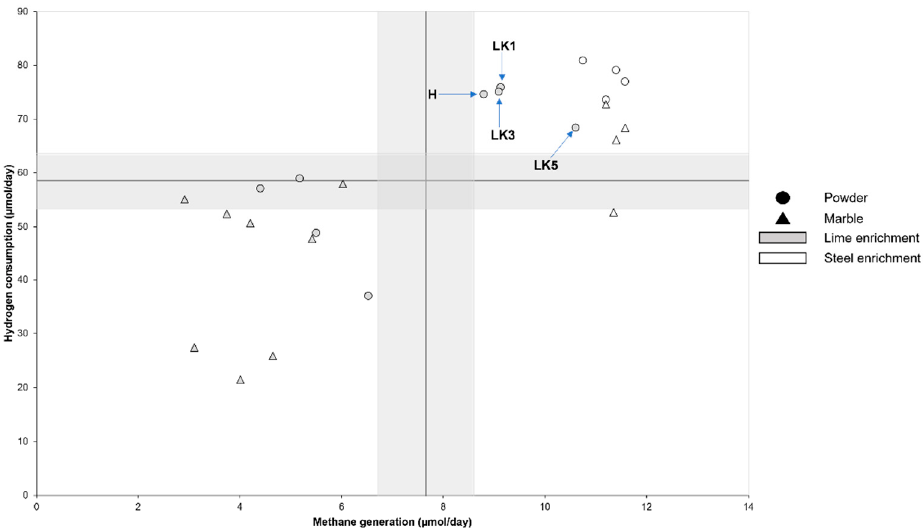
Figure 3. Comparison of hydrogen consumption and methane generation rates across the microcosms. Solid lines and grey area indicate the mean ± SEM of the rates.